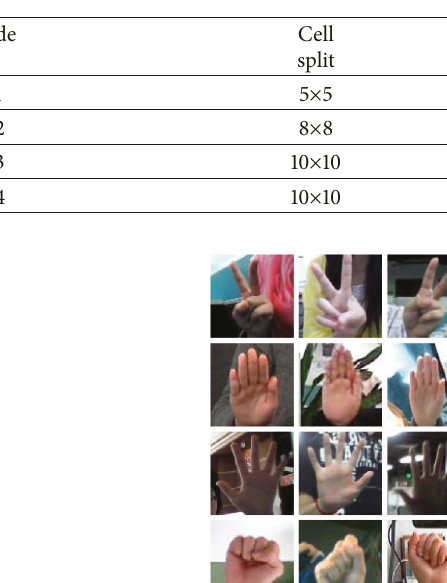
Table 1: The feature configuration for each cascade stage.